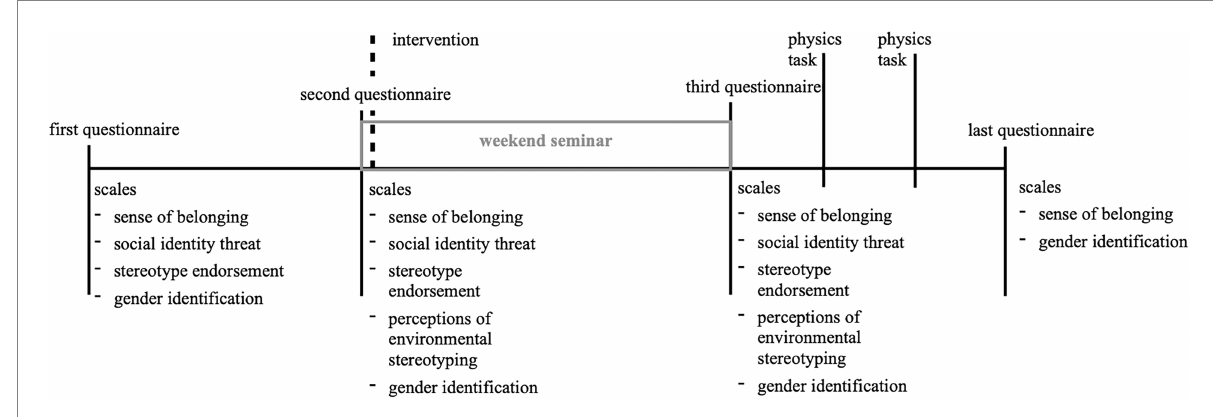
FIGURE 1 Graphical depiction of the study proceedings including the scales, which were used for the